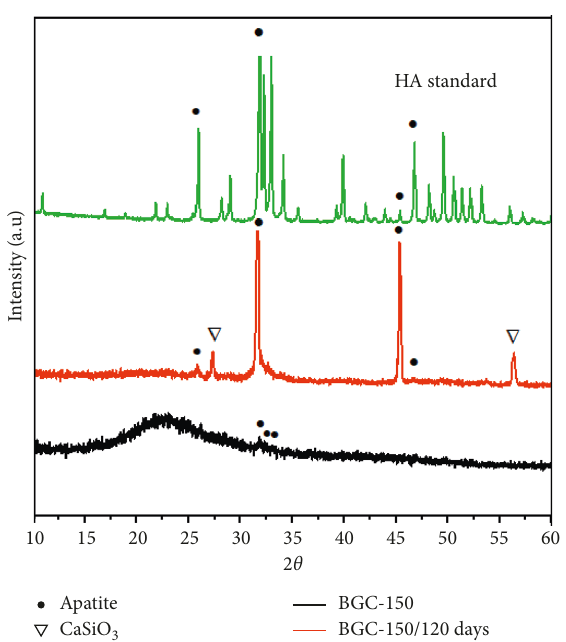
Figure 5: XRD pattern of BGC-150 after 20 days of immersion in SBF solution.